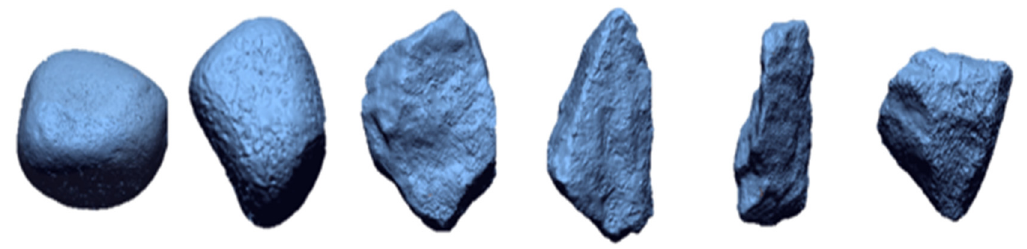
Figure 12. Three-dimensional reconstruction models of coarse aggregates.